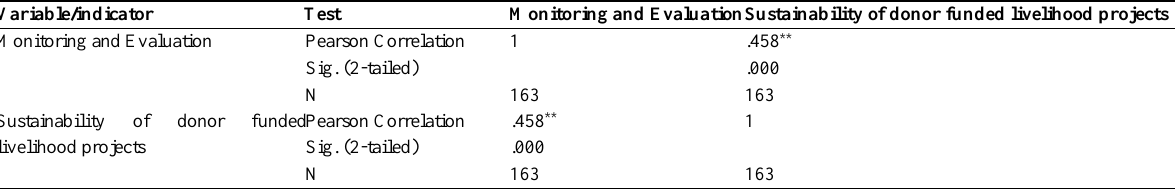
Table 5: Correlation results for monitoring and evaluation and sustainability of donor funded livelihood projects Variable/indicator